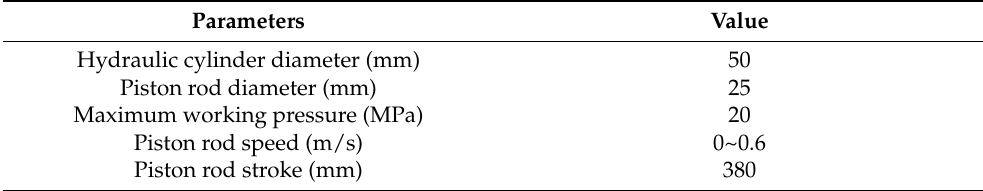
Table 1. Hydraulic cylinder parameters of the high-level extendable working